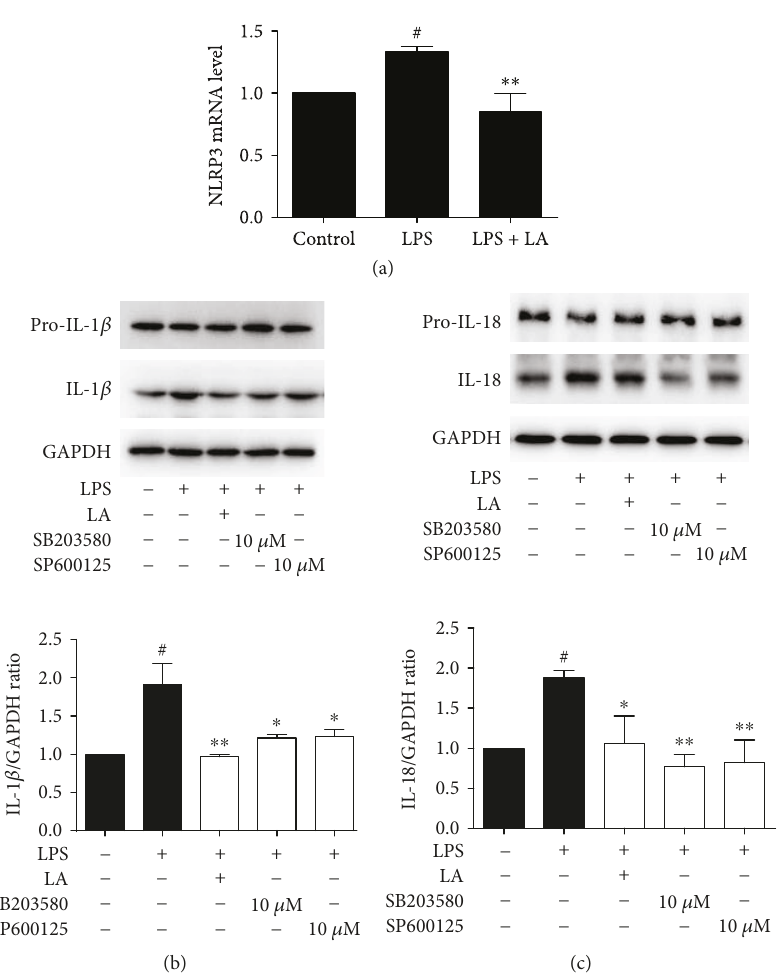
Figure 3: LA suppressed NLRP3 gene and downstream related protein expression. HUVECs were treated with 50 μ M of LA for 1 h, and then LPS was stimulated for 24h. The NLRP3 mRNA level (a) was analyzed using qRT-PCR. LA and p38/JNK inhibitors (SB203580 and SP600125) were treated with HUVECs for 60 min before LPS stimulation for 24 h. NLRP3-associated proteins IL-1 β and IL-18 were detected using immunoblotting (b)(c). Data represent the mean ± SD of at least three independent experiments, and each experiment was performed in triplicate. # p < 0 05 versus control; ∗ p < 0 05 ∗∗ p < 0 01 versus